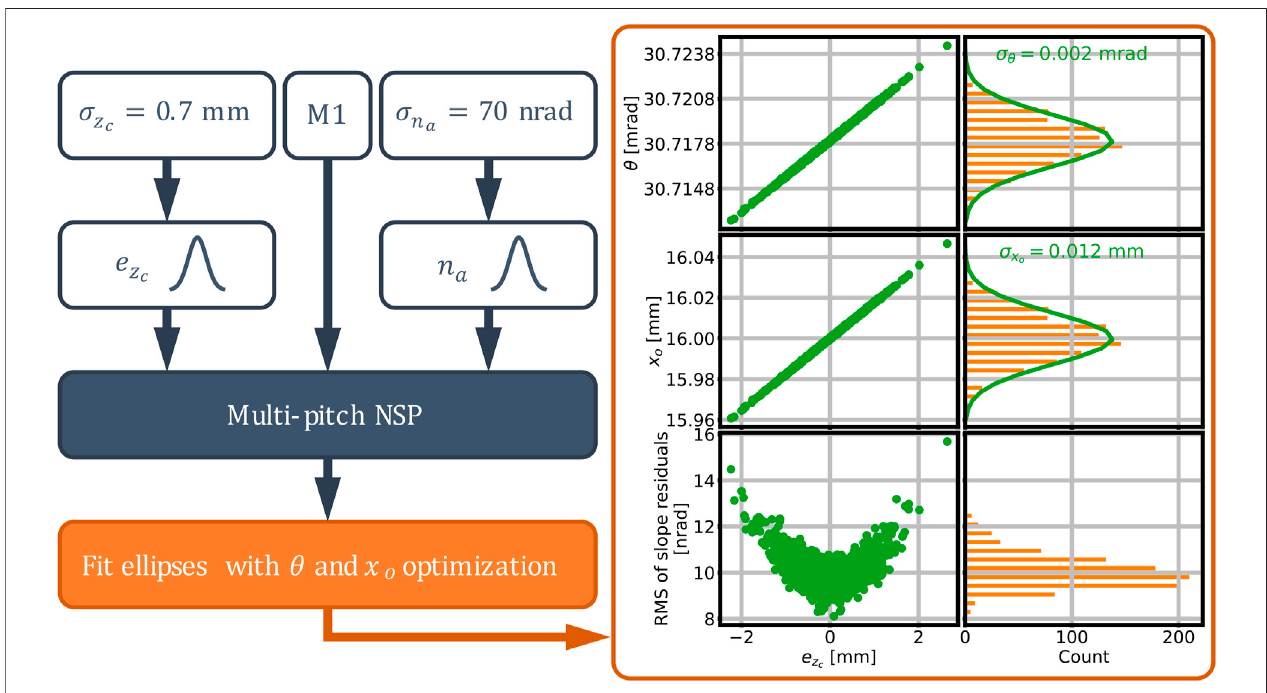
FIGURE 11 | The Monte Carlo simulation of measuring M1 using the multi-pitch NSP with a pitch rotation center measurement error e z σ (cid:2) 0 . 7 mmandanormally-distributedangularnoisewith σ (cid:2) 70 nradgivestheellipse fi ttingresultsofthegrazingangle θ inanuncertaintyof± 3 σ θ (cid:2) ± 6 µrad,the x z c n a (cid:2) ± 36 µm, and the RMS of the slope residuals from the best fi t around 10 ± 2 nrad with an uncertainty of ± 3 σ x o